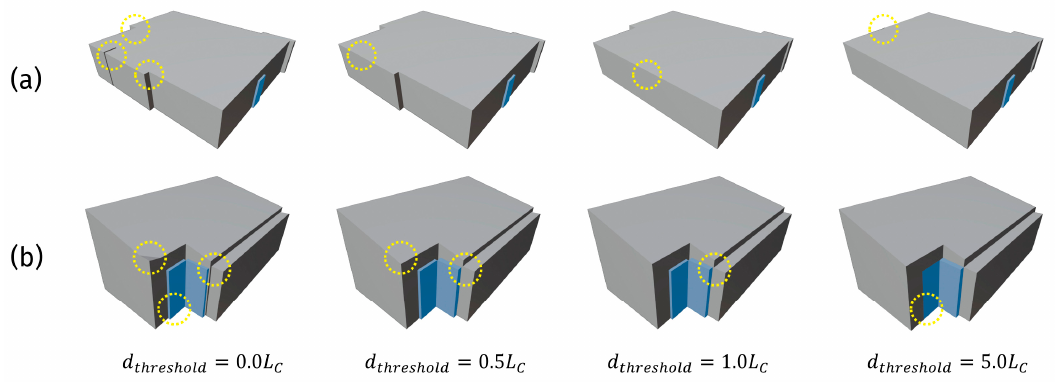
Figure 6. Simplification of typical building geometry. ( a ) Space 1E24 of Medical Clinic, ( b ) Space 04 of Academic